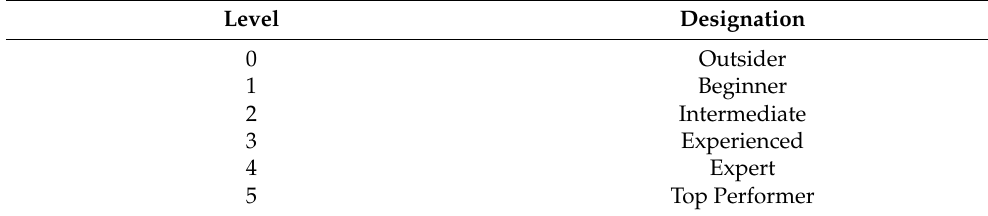
Figure 2. Diagram illustrating the approach used in this study. Source: Authors’ compilation. Table 4. Levels of implementation.